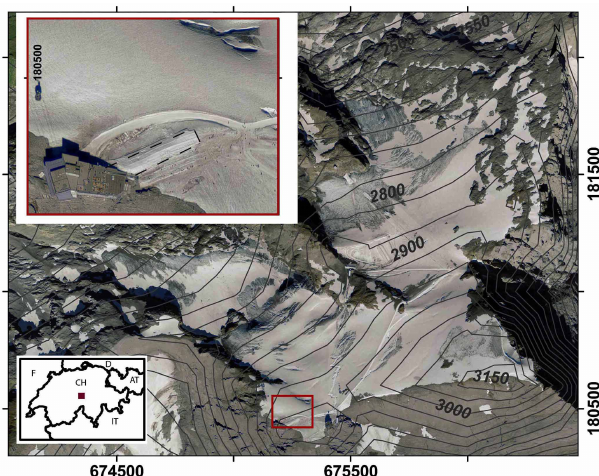
Figure 1. The study site on Titlis glacier, central Swiss Alps. The ice tunnel is adjacent to the cable car station on Chli Titlis summit (red square in overview map). The enlargement corresponds to the red square, and the broken black line shows the position of the ice tunnel under the glacier surface. Note the lighter shading of the sur- face above the ice tunnel due to surface covers. The orthophotos and elevation data have been kindly provided by Swisstopo (Swissim- age and DHM25/200; swi, 2017a, b). GPS coordinates are reported in the Swiss grid